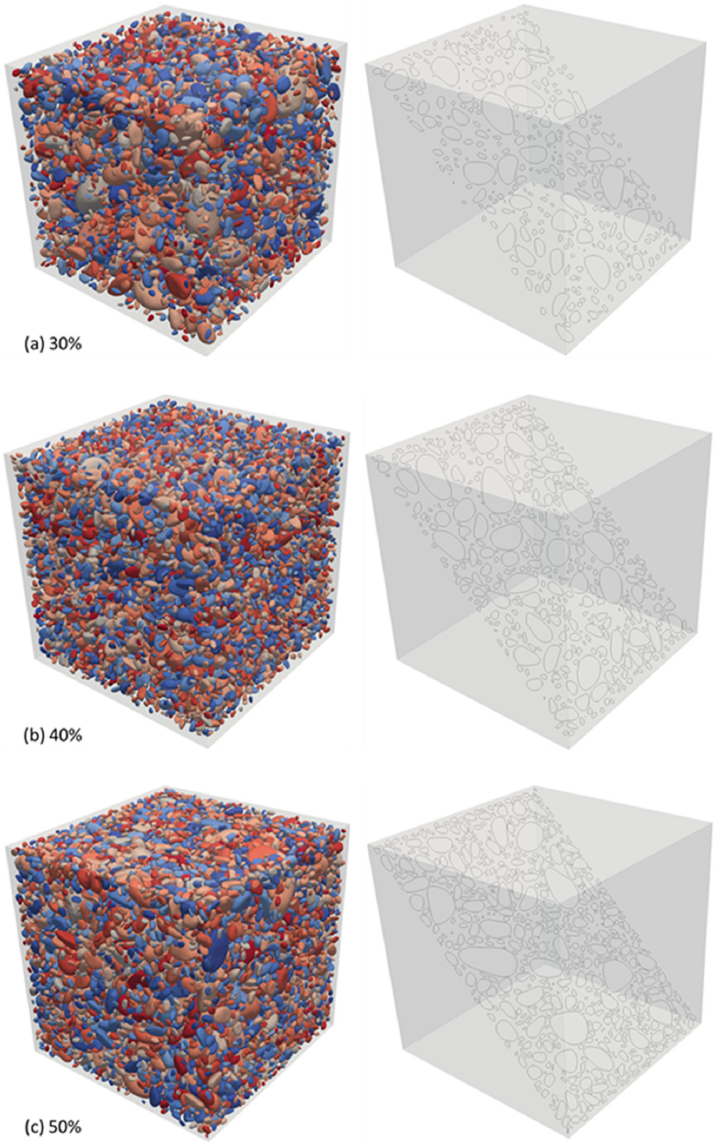
Figure 20. Numerical concrete models by rounded polyhedrons (where every right section represents the corresponding slice to help check if there is any overlapping aggregate conveniently), among which the aggregate volume fractions are ( a ) 30%, ( b ) 40%, and ( c ) 50%, respectively.